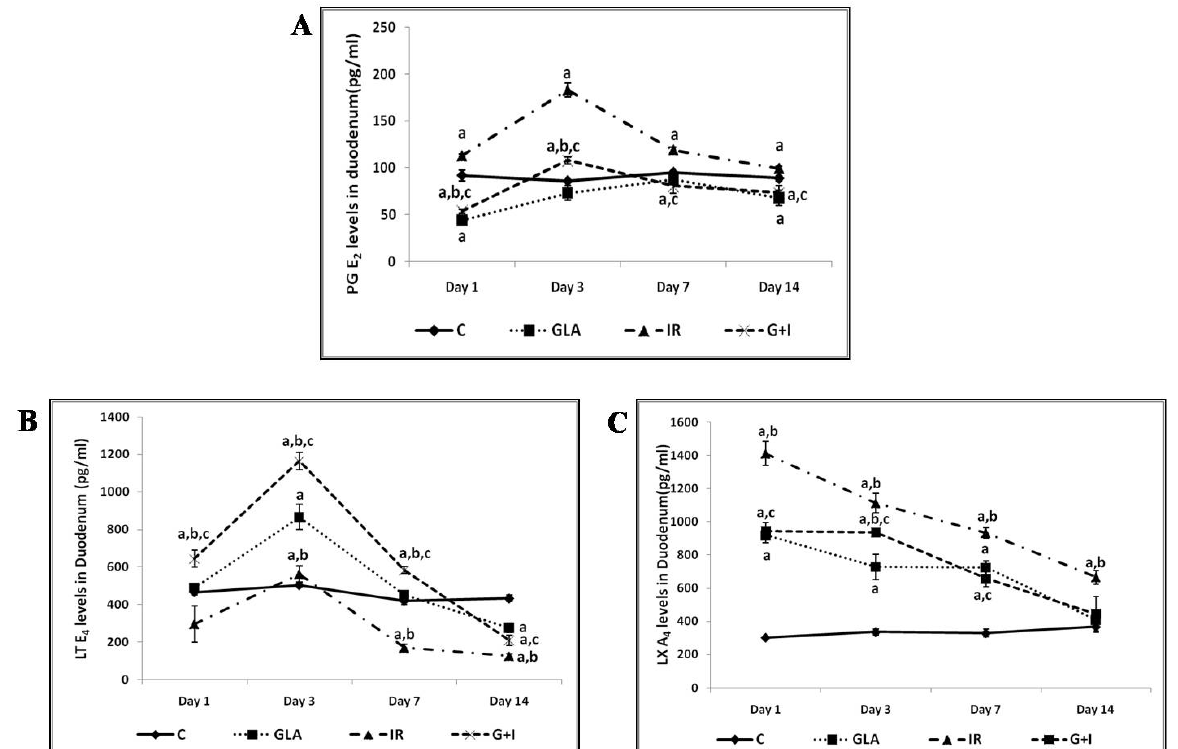
Figure 13. Estimation of PUFA metabolite PG E 2 ( A ), LT E 4 ( B ), and LXA4 ( C ) levels by ELISA method. Mice were pre-treated with 100 μ g/kg GLA at 48, 24, and 1 h prior to irradiation, and were subjected to total-body irradiation of 7.5 Gy (at 1 Gy/min). Duodenum samples were obtained on day 1, day 3, day 7, and day 14 post-irradiation. All the values are expressed as mean ± SEM (n = 3). Statistical significance was calculated using t -tests, and p -values < 0.001 are represented by a , b , c when compared to control, GLA, and IR, respectively. C, control; GLA, gamma-linolenic acid; IR, irradiation (7.5 Gy).